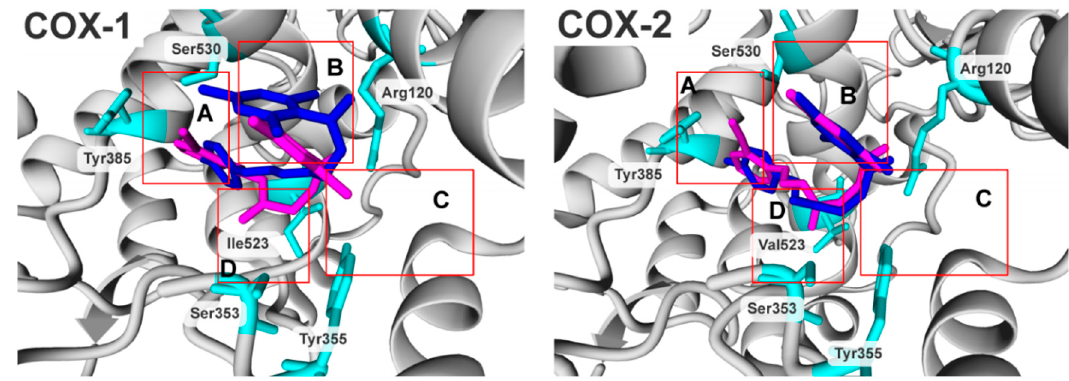
Figure 3. Docking poses of PS33 (blue) and PS43 (magenta) under COX-1 and COX-2 binding domain conditions. Residues coloured cyan; all hydrogens were hidden. A, B, C, D: binding subdomains corresponding to Figure 2; details are given in the text.